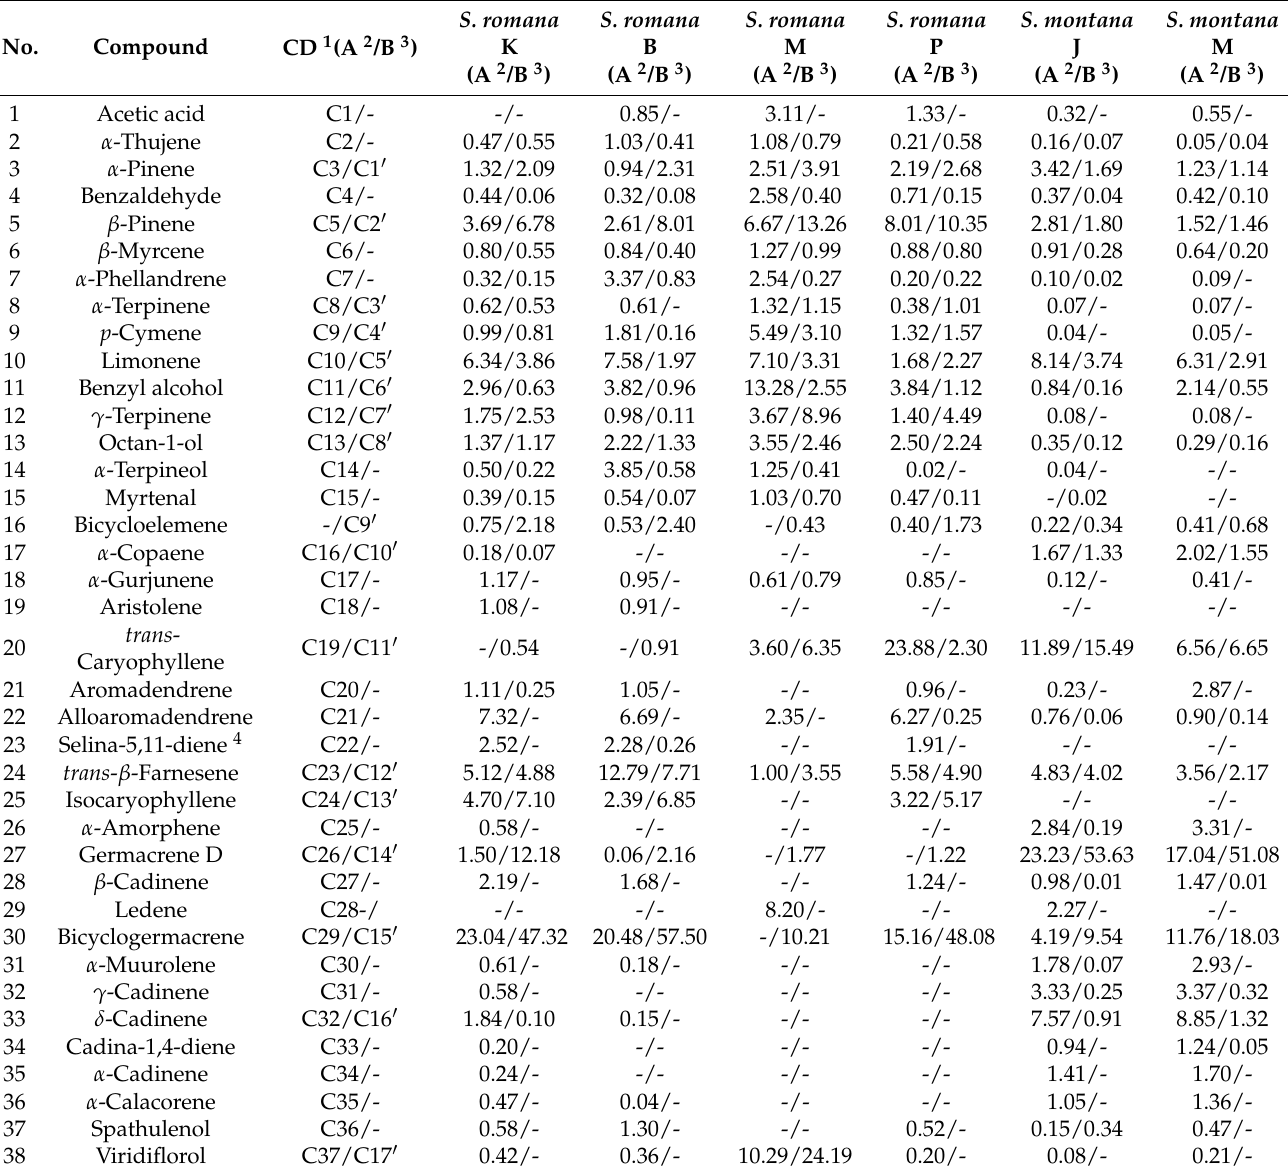
Table 3. Composition (%) of major identified VOCs of S. romana and S. montana obtained by HS-SPME/GC-MS with DVB/CAR/PDMS and PDMS/DVB